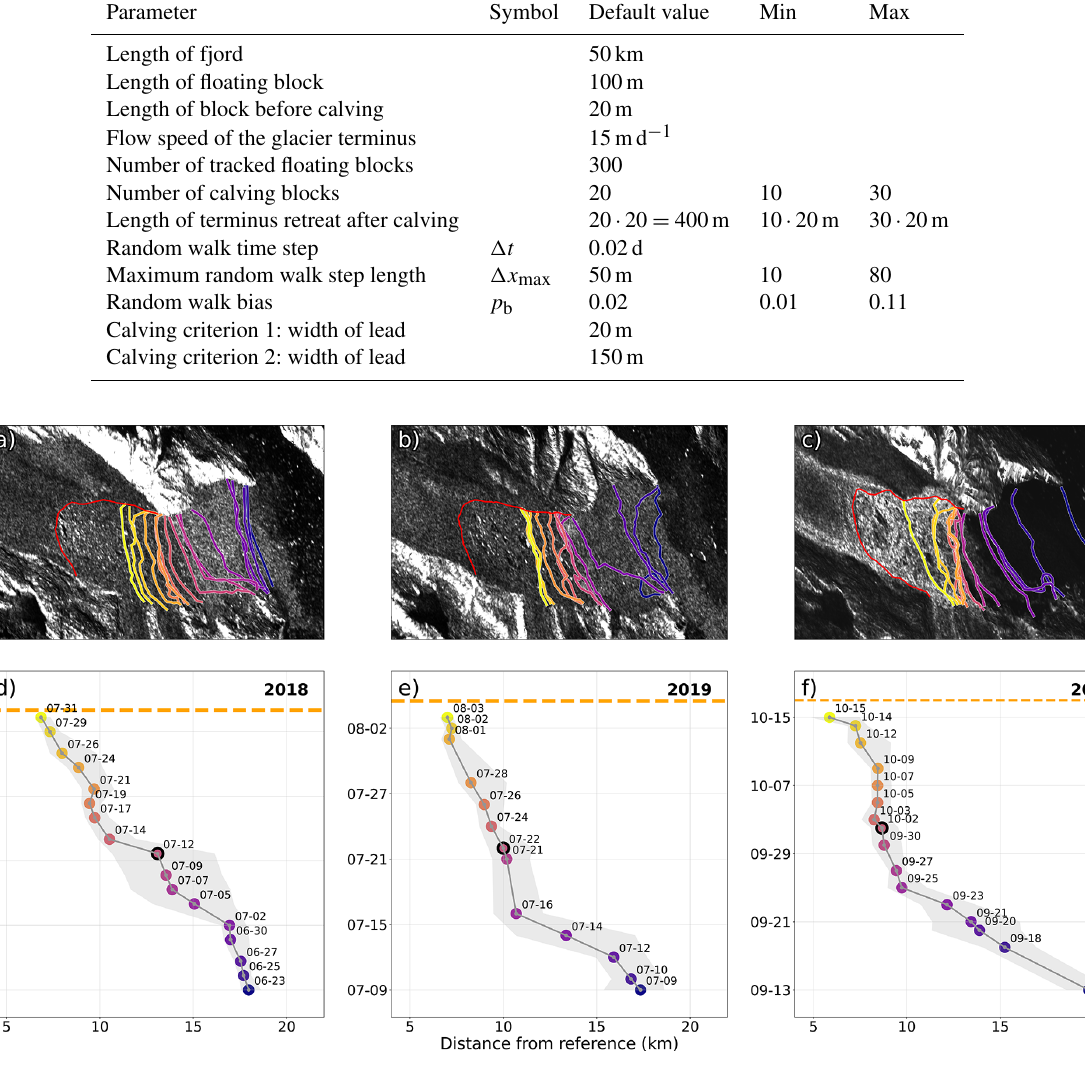
Figure 2. Three IMW episodes at KG. (a–c) Positions of the IMW fronts through time in Cartesian coordinates, overlaying Sentinel-1 HH images acquired half-way through each IMW episode (Copernicus Sentinel data 2022, processed by ESA). Red lines correspond to the position of the calving front. (d–f) Distance between IMW fronts and an on-ice reference situated 1km upstream from the most retreated glacier terminus position mapped in the data set. Dot color corresponds to each IMW front mapped in (a) – (c) through time and black dot contours to the acquisition dates of the respective Sentinel-1 HH images. The gray curves indicate the median along-fjord distance of the IMW front from the on-ice reference. The envelopes correspond to the range between minimum and maximum along-fjord distance at each time steps (therefore quantifying the across-fjord variations in IMW front position). Horizontal orange dashed lines indicate the timing of calving events detected with spaceborne observations, with their width being proportional to their approximated magnitude (small, medium or large). Time is running from bottom